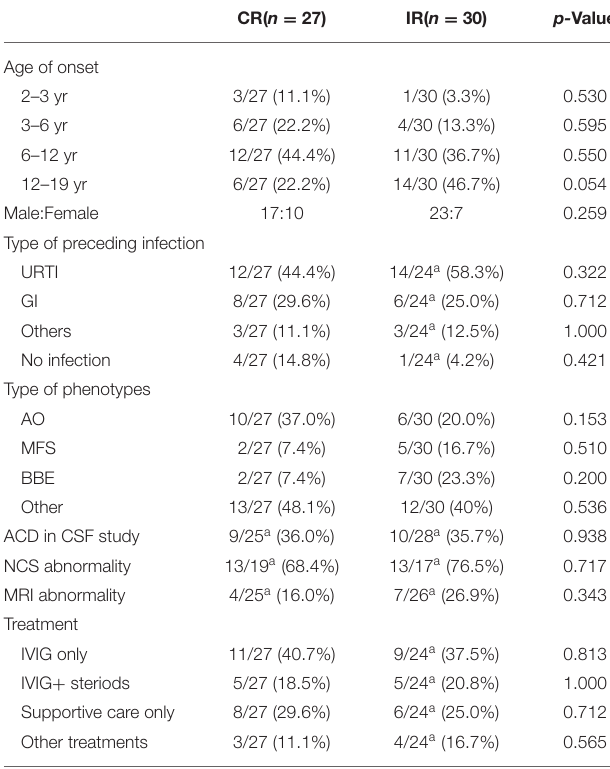
TABLE 3 | Comparison between complete and incomplete recovery